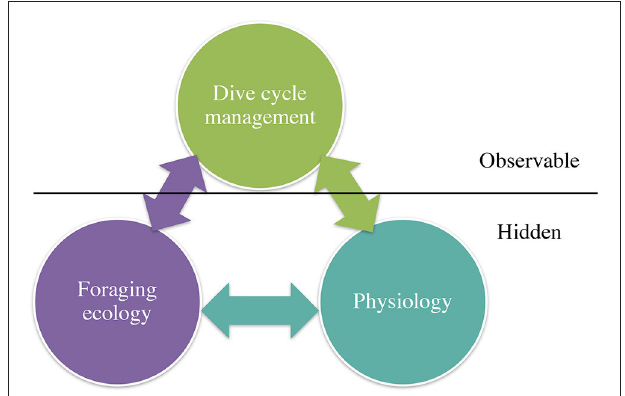
FIGURE 1 | Diagram showing the interplay between what is “observable” and can be measured, i.e., dive behavior and dive cycle management; and what can be inferred, i.e., about foraging and physiology, and may be considered “hidden”